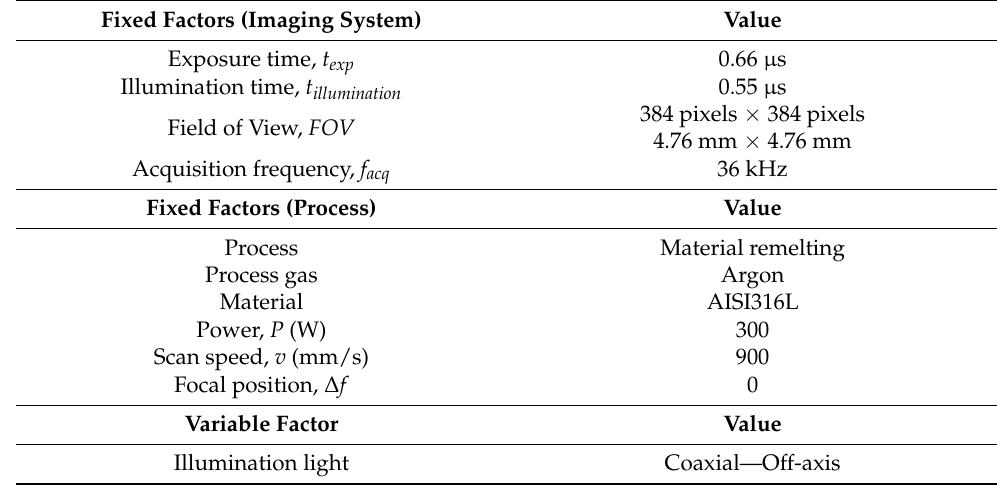
Table 5. Configuration of the high-speed imaging acquisition system on the Raylase AM module to evaluate the detectability of surface oscillations with different illumination conditions.